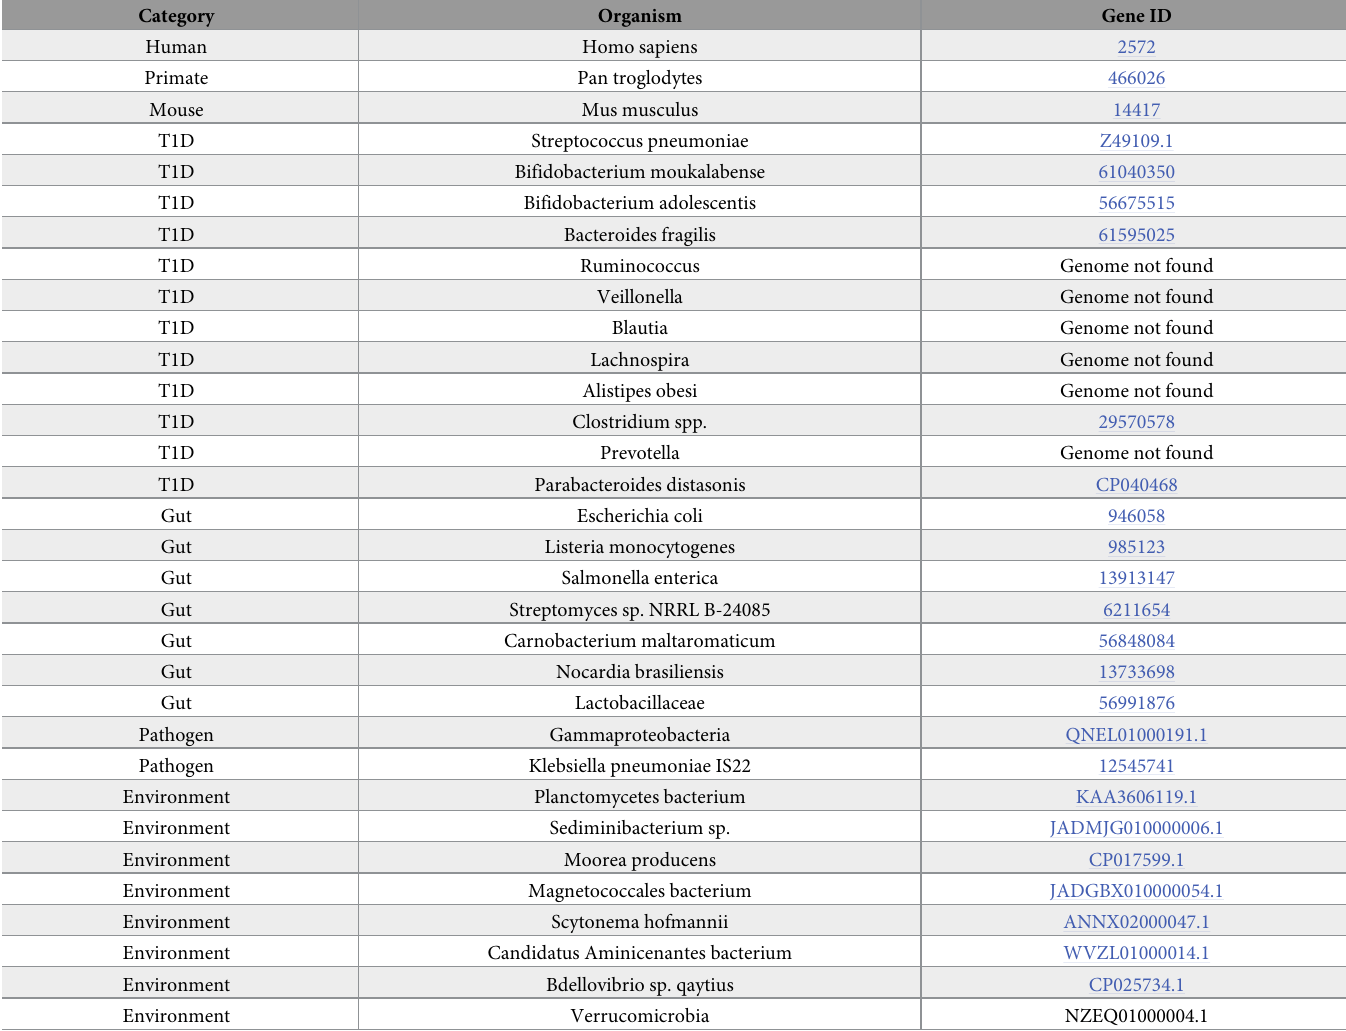
Table 1. GABA producing bacterial species and their respective GAD